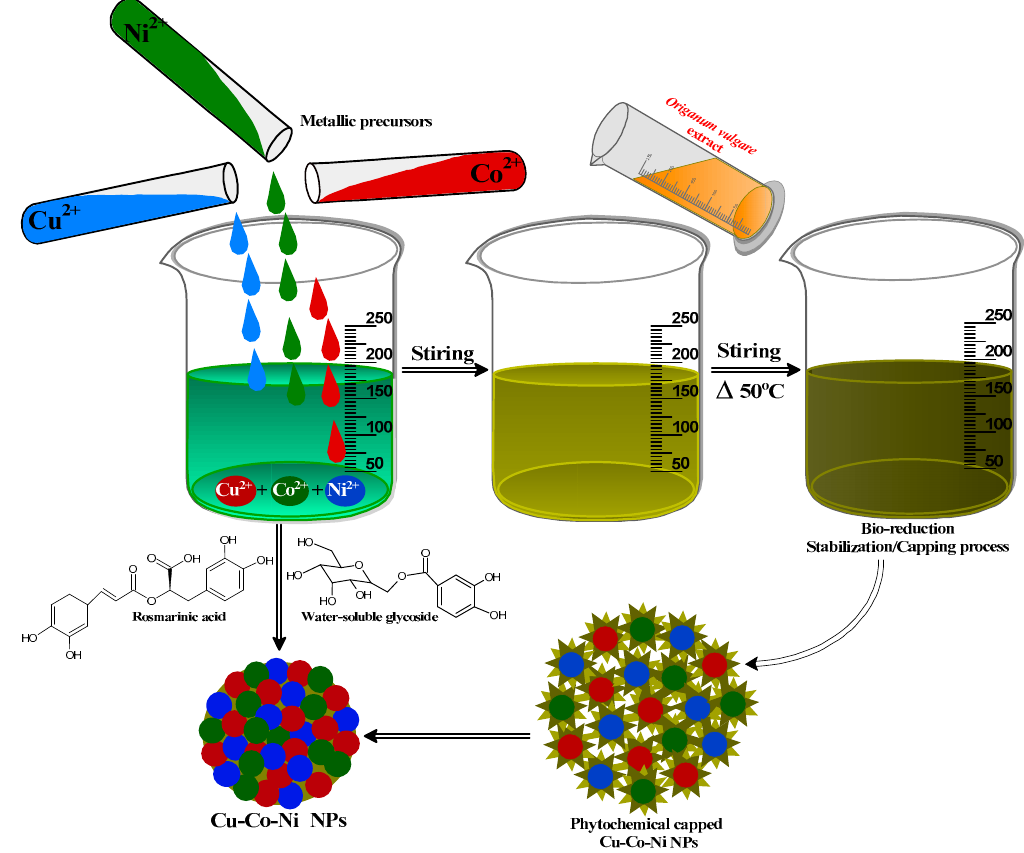
Figure 2. The systematic illustration for the synthesis of tri-metallic Co-Cu-Ni nanoparticle composite reduces rosmarinic acid and water-soluble glycosides.